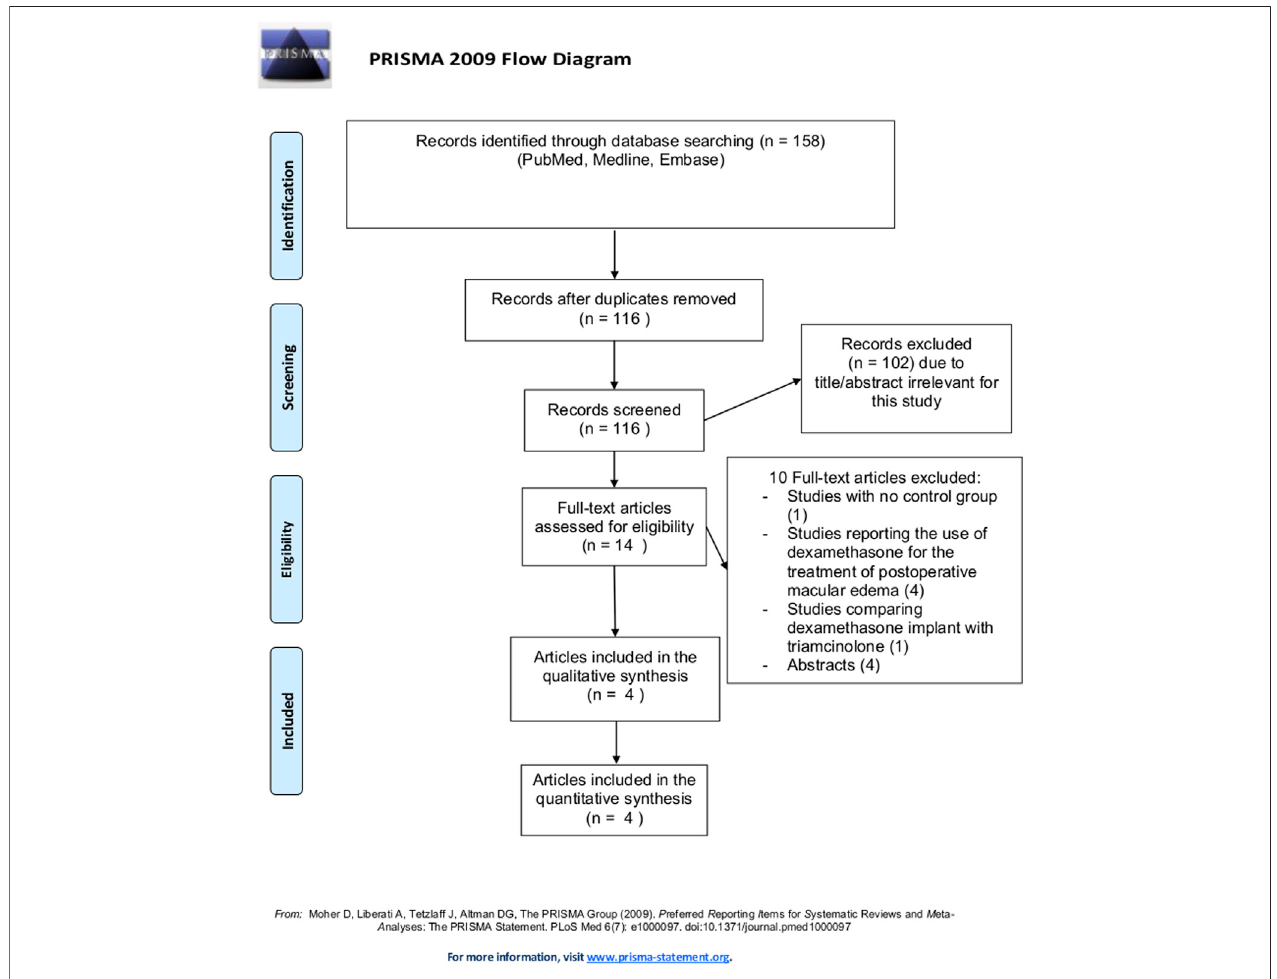
FIGURE 1 | Flow chart of study selection